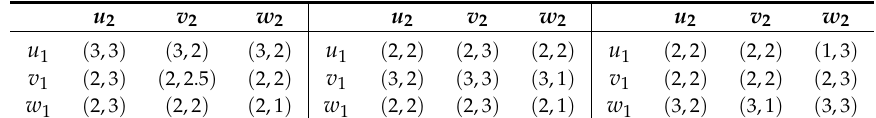
Figure 3. The partition of the type space of Agent 2 for each extreme type of Agent 1 in the multigame of Example 4. The multigame has no compatible pure ex post NE by Theorem 2. The type θ 2 = ( 1/4,1/4,1/2 ) shows that the partition of Θ ∈ Θ e . 2 is not independent of θ 1 1 Table 7. Utilities for basic games G 1 , G 2 and G 3 of Example 4.